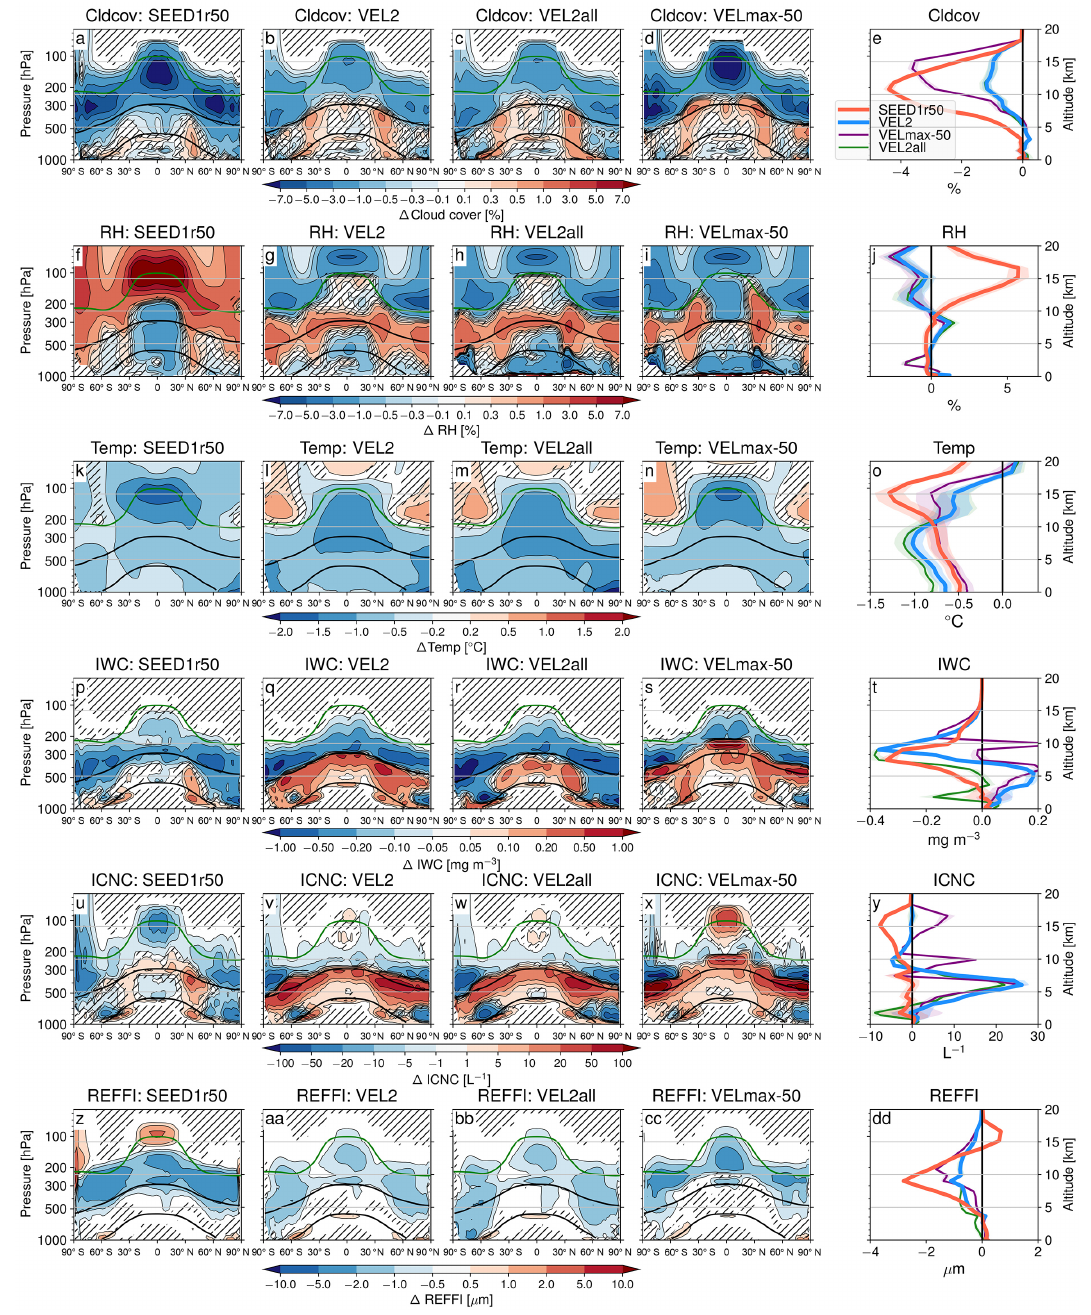
Figure 5. Annually averaged anomalies of cloud cover (Cldcov, a–e ), relative humidity with respect to liquid water (RH, f–j ), temperature (Temp, k–o ), all-sky ice water content (IWC, p–t ), all-sky ice crystal number concentration (ICNC, u–y ), and all-sky ice crystal effective radius (REFFI, z–dd ) for the SEED1r50 and VEL2 MLO simulations (see Table 1). The green curve represents the tropopause, and the black curves the − 35 ◦ C and the 0 ◦ C isolines. The hatching is applied for anomalies not significant at the 95% confidence level. On the right-hand side the anomalies are averaged over latitude and